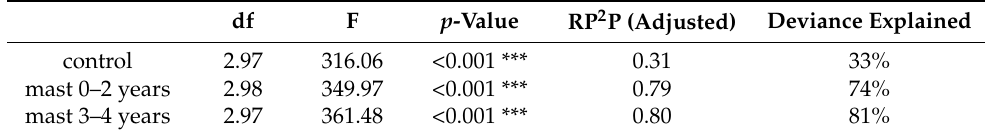
Table A1. Diagnostics of the GAM models developed for shrub density for masticated and control. Statistical significance denoted by *** p ≤ 0.001.